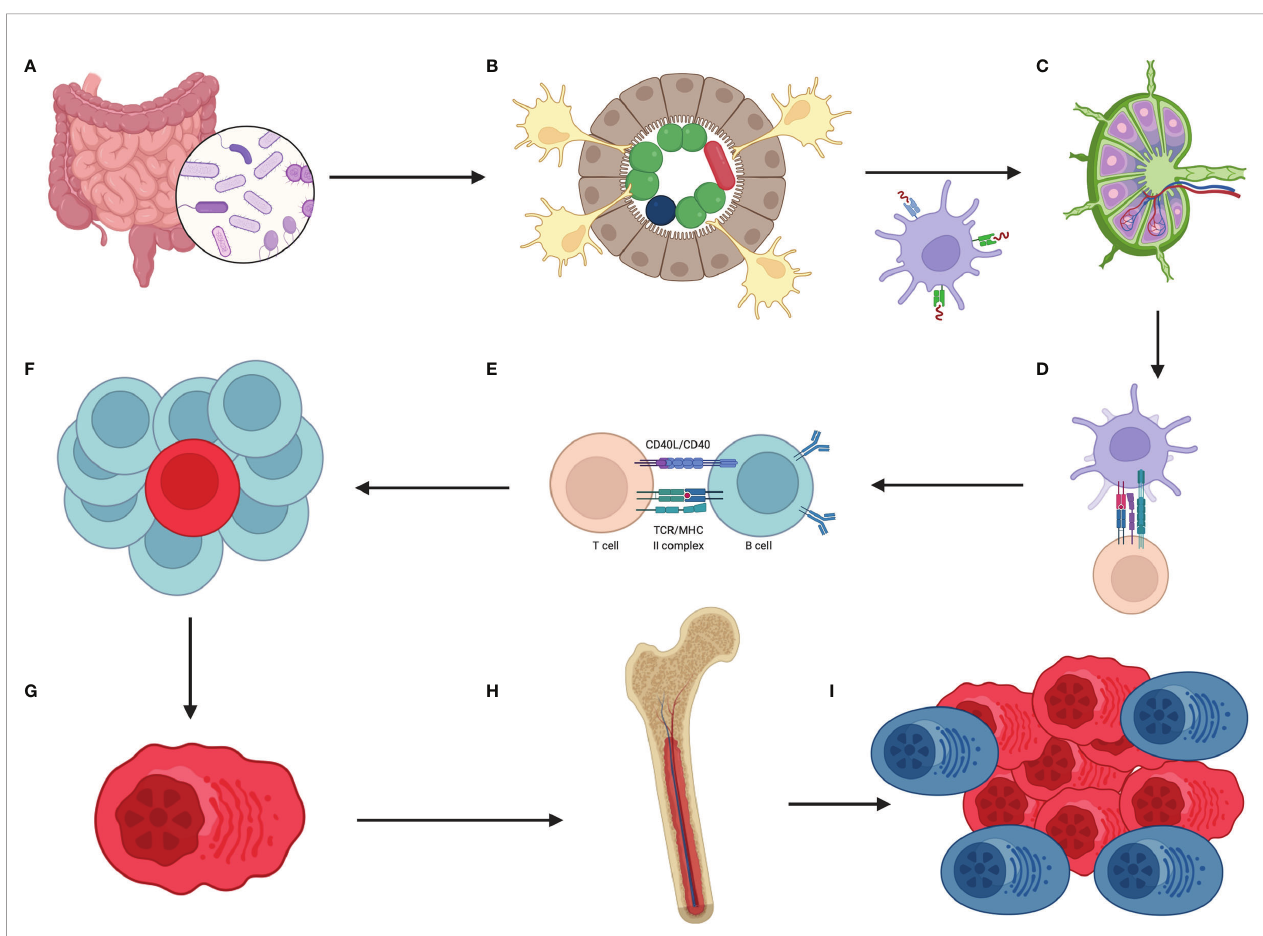
FIGURE 2 | How the hypothetical pathway from dysbiosis to multiple myeloma looks? The sequence of events is as follows (A) lack of balanced gut microbiota which means overgrowth of selected species of bacteria (B) these bacteria are accountable for constant, oligo- or even monoclonal stimulation of DCs (with help of IECs) which migrate to mesenteric lymph nodes and/or Peyer ’ s patches (C) there, B cells, T cells and mentioned DCs meet each other (D) DCs are presenting this oligo-, monoclonal antigens to T cells (E) which then are responsible for selection of B cells that are going to have required features to combat the antigen (F) because of continuous stimulation in the gut the process of B cell selection is intense and these cells undergo numerous rounds of proliferation which are preceded by SHM and class switching, associated with DNA changes (G) one initial B cell with driver mutation emerges, transforms to plasma cell that produces oligo-, monoclonal antibodies against the antigen, and proliferates (H) then plasma cells migrate to bone marrow which is the site of constant immunoglobulins production (I) when mutated plasma cells acquire additional mutations and are surrounded by favorable milieu then initial state of MGUS changes into SMM, MM and eventually to PCL. Created with